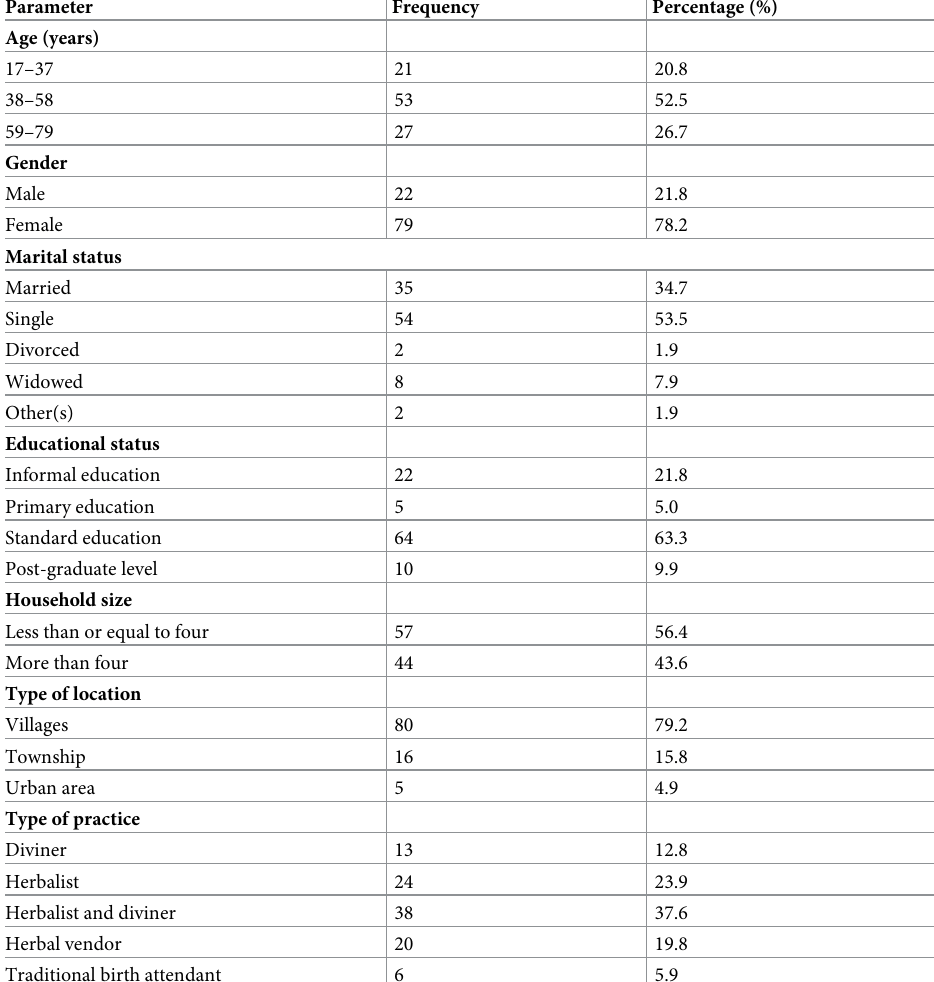
Table 2. Demography of the participants with knowledge on child-related diseases in Ngaka Modiri Molema and Bojanala districts of North West Province, South Africa (n = 101).